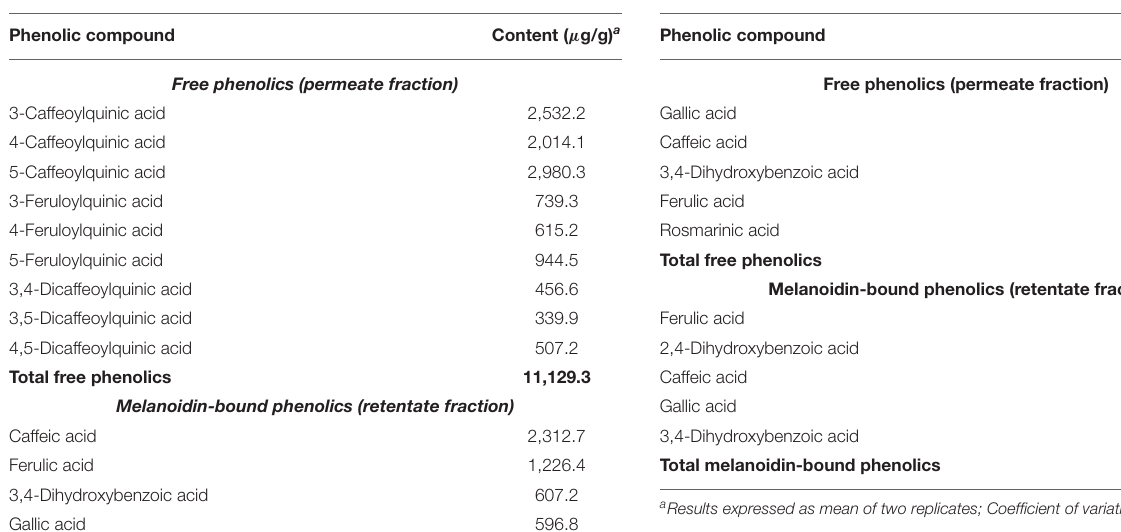
TABLE 1 | Free and melanoidin-bound phenolic compounds in coffee. TABLE 2 | Free and melanoidin-bound phenolic compounds in